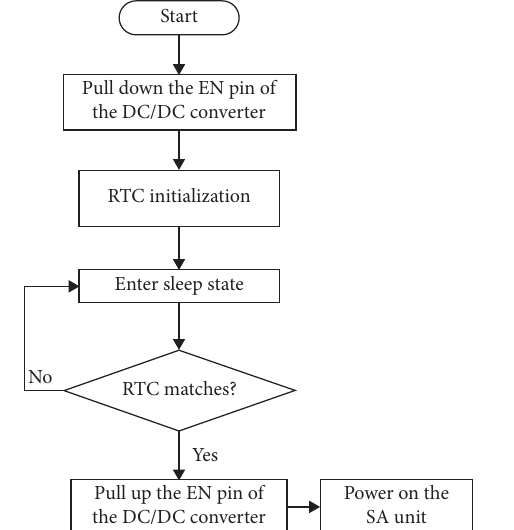
Figure 6: Working mechanism of the standby mode for the LPM